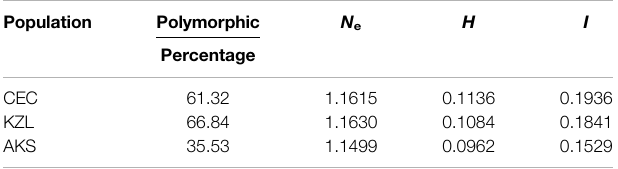
TABLE 3 | 20 microsatellite locus genetic variation of S. biddulphi . Locus